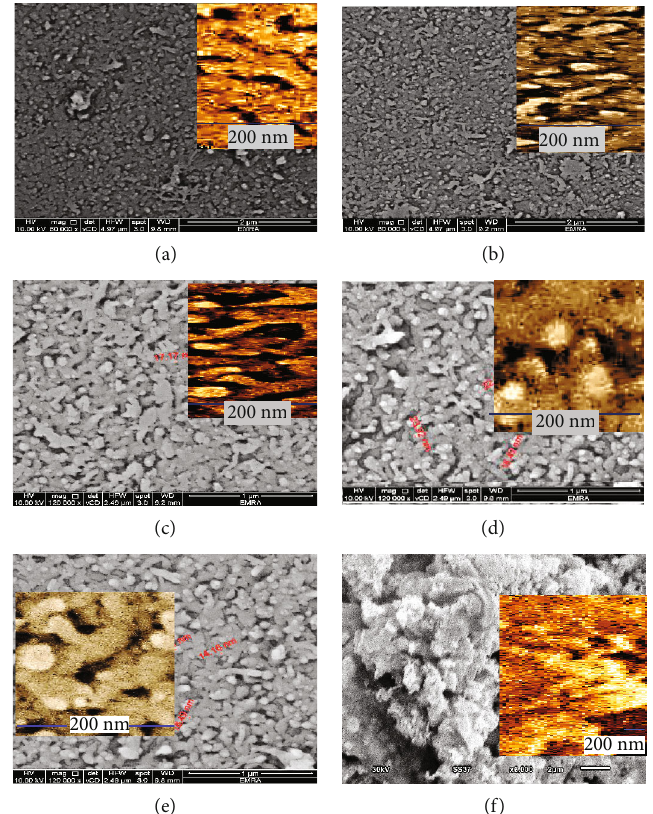
Figure 2: The SEM image of (a) P3MA, (b – e) P3MA/PbS-QD composite with di ff erent Pb 2+ ion concentrations of 0.01, 0.03, 0.05, and 0.07M, respectively, and (f)